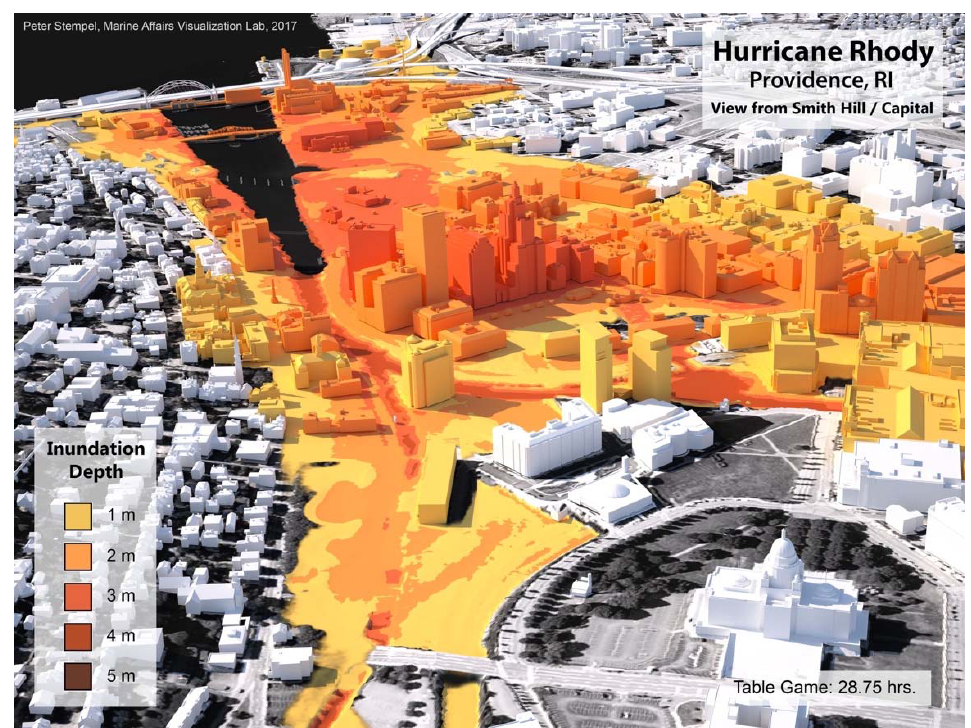
Figure 15. Inundation of downtown Providence by river flooding based on a possible failure of the Fox Point Hurricane Barrier. The realization of this scenario involves multiple uncertainties regarding the performance of infrastructure and human responses. The coloration of the structures reflects flooding at ground level. With adequate facility information, the structures may be separately controlled. This example demonstrates how the capacity to visualize 3D space may exceed the capability of the impact model or our understanding of the underlying uncertainties. Image: Authors.